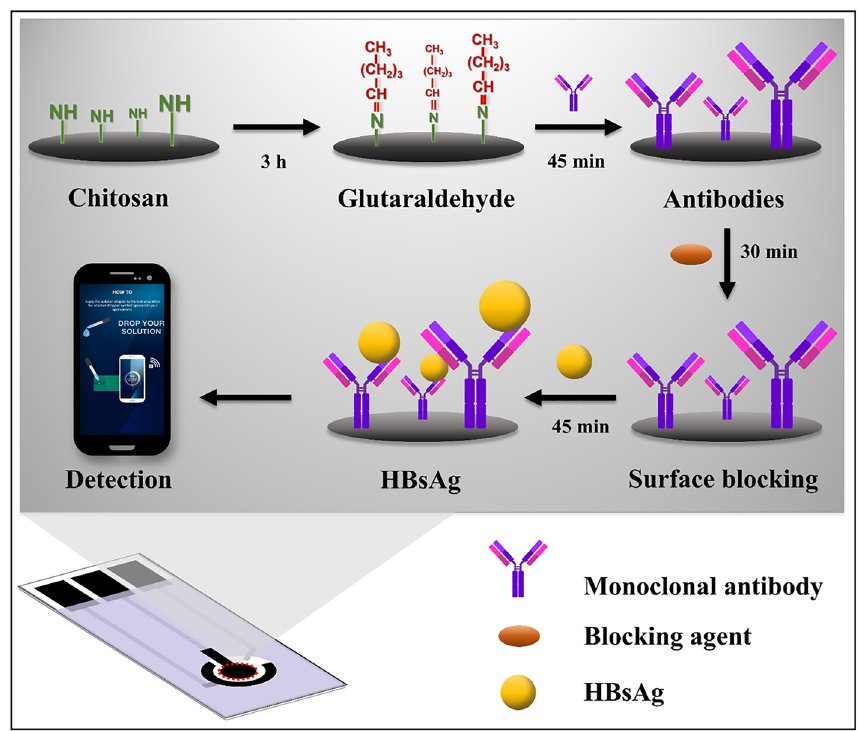
Figure 6. Schematic illustration of stepwise electrode modification for HBsAg electrochemical